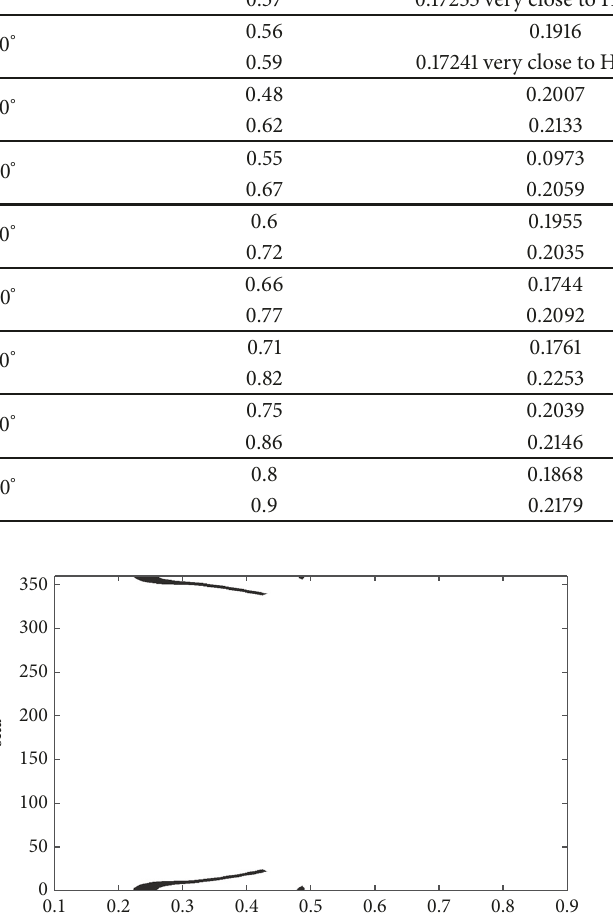
steady ratios as long as the closest distance satisfies 𝑟 ROI ≤ r 1 ≤ 𝑟 Hill and the temporary Kepler energy H 2 ≤ - ROI